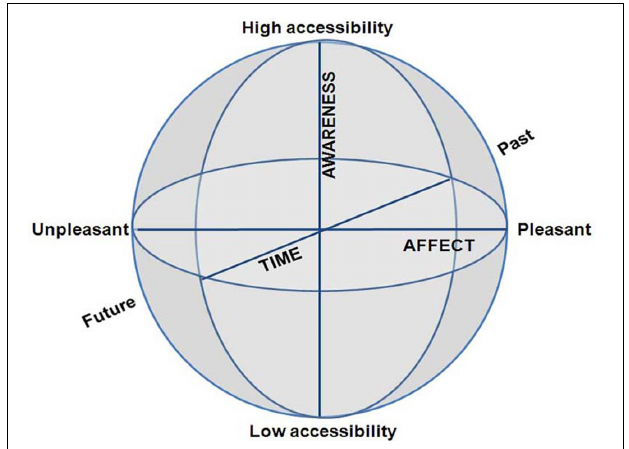
FIGURE 2 | The Consciousness State Space (CSS), depicting a phenomenological space with three psychological